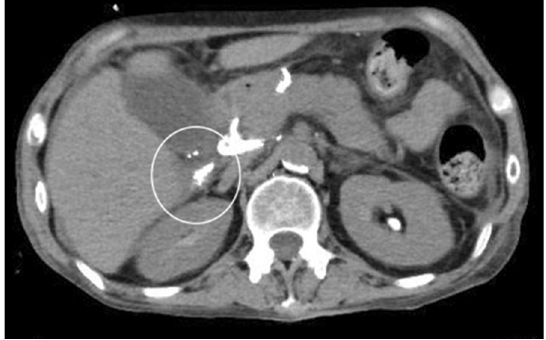
Fig. 4 Findings of leakage disappeared in the imaging after